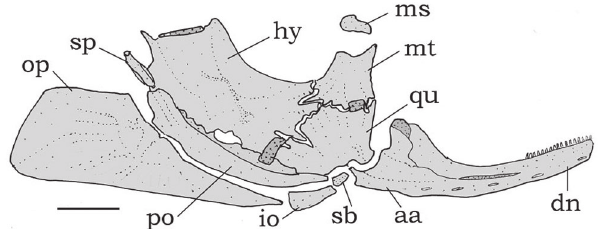
Fig. 3. Right suspensorium of Centromochlus britskii , MZUSP 43251, paratype, 35.9 mm SL. Lateral view.